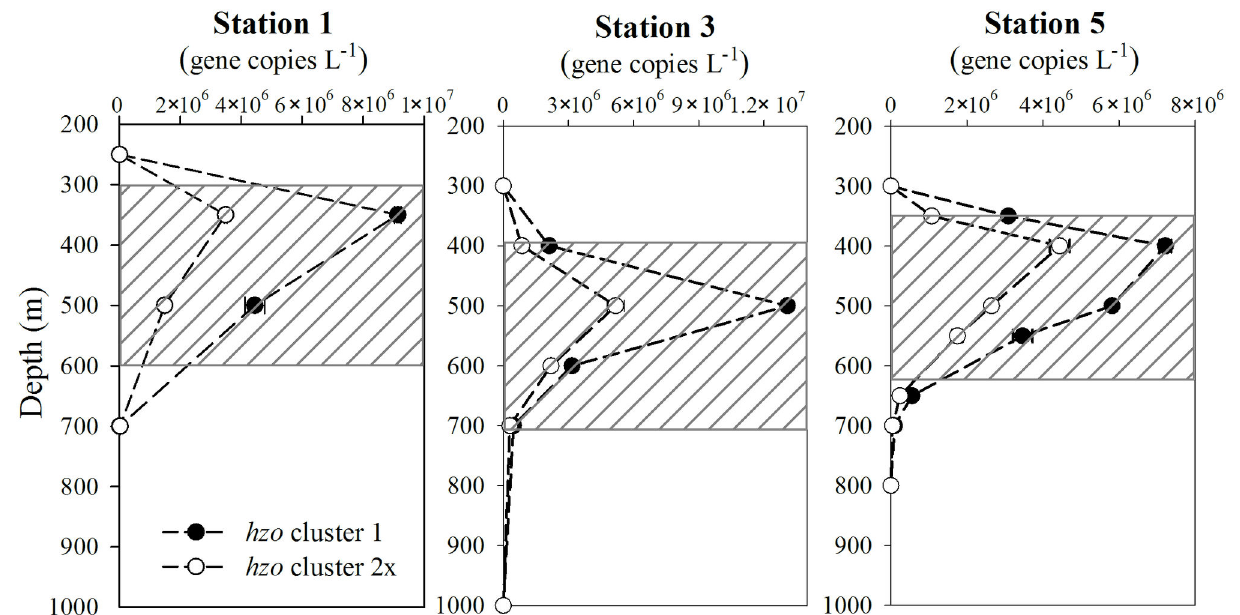
Figure 5. Vertical profiles of hzo cluster 1 and cluster 2x gene abundances in the smaller size fraction (0.2-2.0 μm) among different stations in Costa Rica Dome (CRD). Shadow layers show the core of the oxygen minimum zone (OMZ) characterized by dissolved oxygen concentration lower than 1.0 μM.